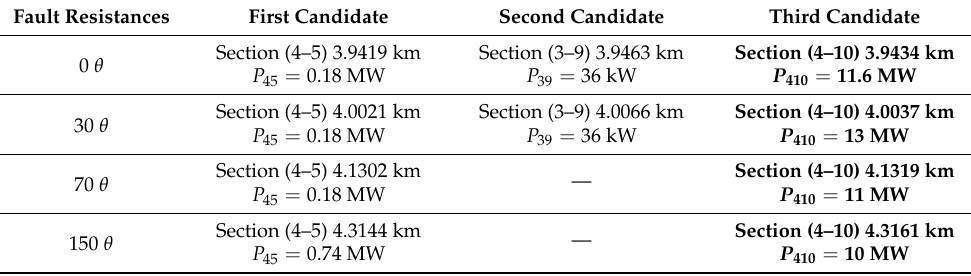
Table 3. Proposed Method Effectiveness under Different Fault Inception